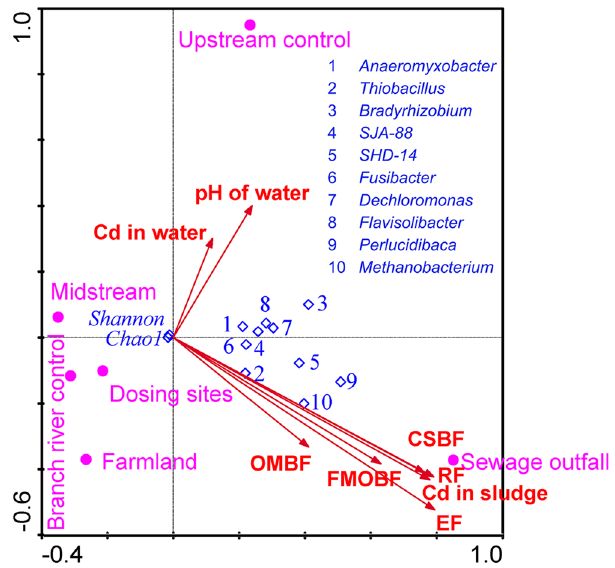
Figure 5. Canonical correspondence analysis. Canonical correspondence analysis triplots show the relationship between microbial composition at the genus level and sample properties. Samples are shown with solid circles, environmental parameters with solid line and solid arrows, and species, microbial richness (Chao1 index) and diversity (Shannon index) with diamonds. Exchangeable Fraction (EF), Carbonate and Sulphide Bound Fraction (CSBF), Fe and Mn Oxide Bound Fraction (FMOBF), Organic Matter Bound Fraction (OMBF), Residue Fraction (RF).